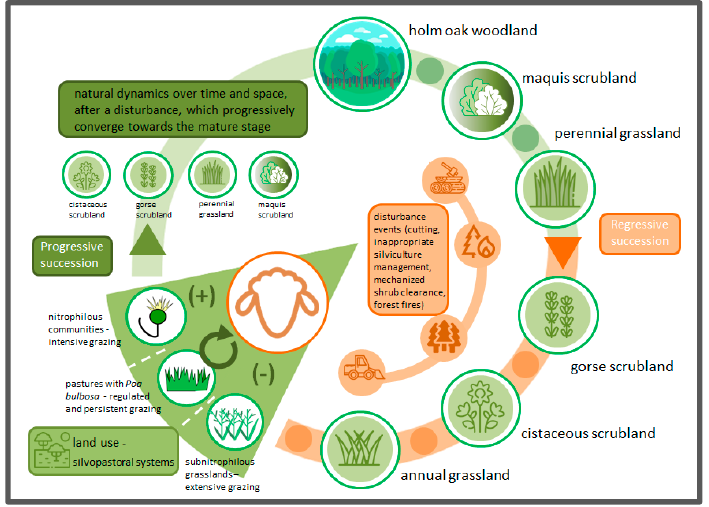
Figure 3. Diagram representing the typical sequence of vegetation stages occurring in the holm oak vegetation series from southwest of Iberian Peninsula.